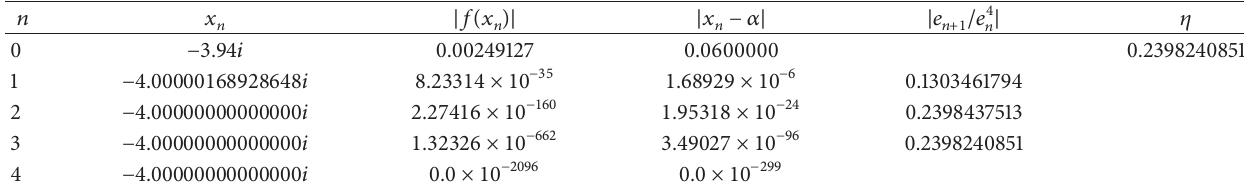
Table 3: Convergence behavior with 𝑓(𝑥) = (16 + 𝑥 2 ) 3 ( log (𝑥 2 + 17)) 4 , (𝑚,𝜆, 𝜌) = (7,1, −1) , 𝛼 = −4𝑖